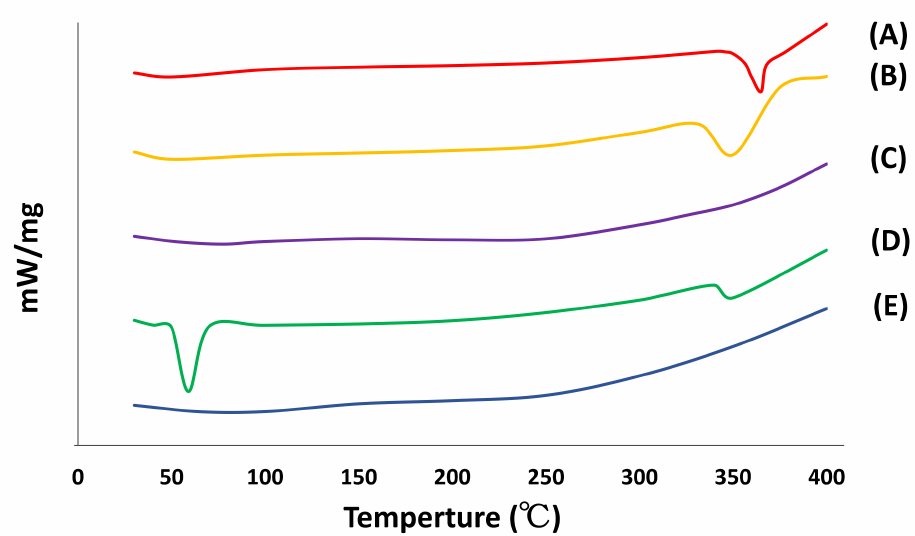
Figure 5. DSC curves of apigenin, pharmaceutical excipients, and the apigenin-loaded film. (A), Apigenin; (B), HPMC; (C), Carbopol; (D), Poloxamer; (E), apigenin-loaded